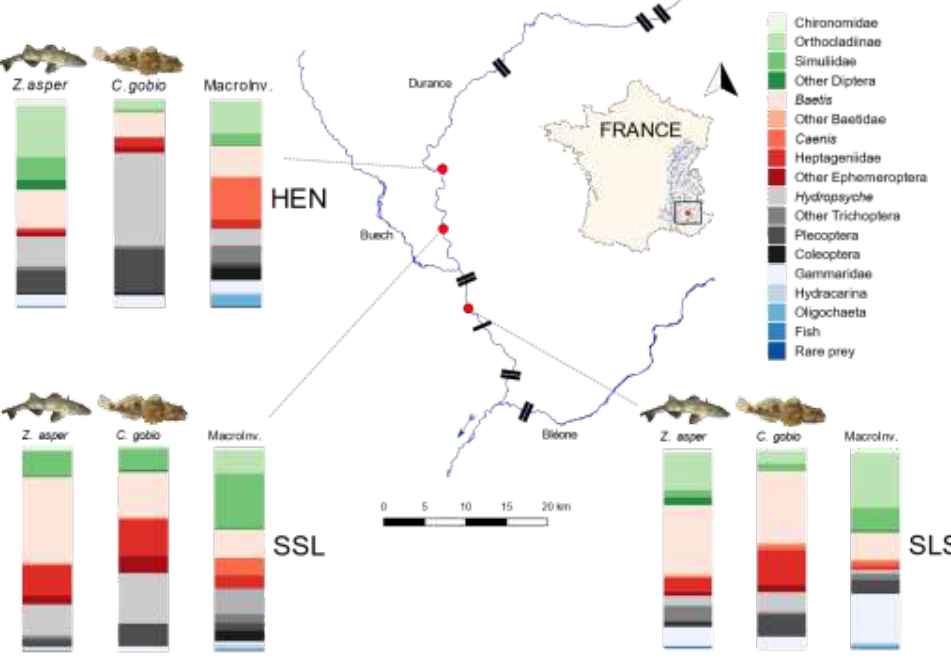
Figure 1. Relative prey consumption by Zingel asper and Cottus gobio and relative macroinvertebrate abundance in the environment. Red points indicate sampling sites, double black lines indicate dams, the single black line indicates a weir, and the arrow indicates the direction of river flow.